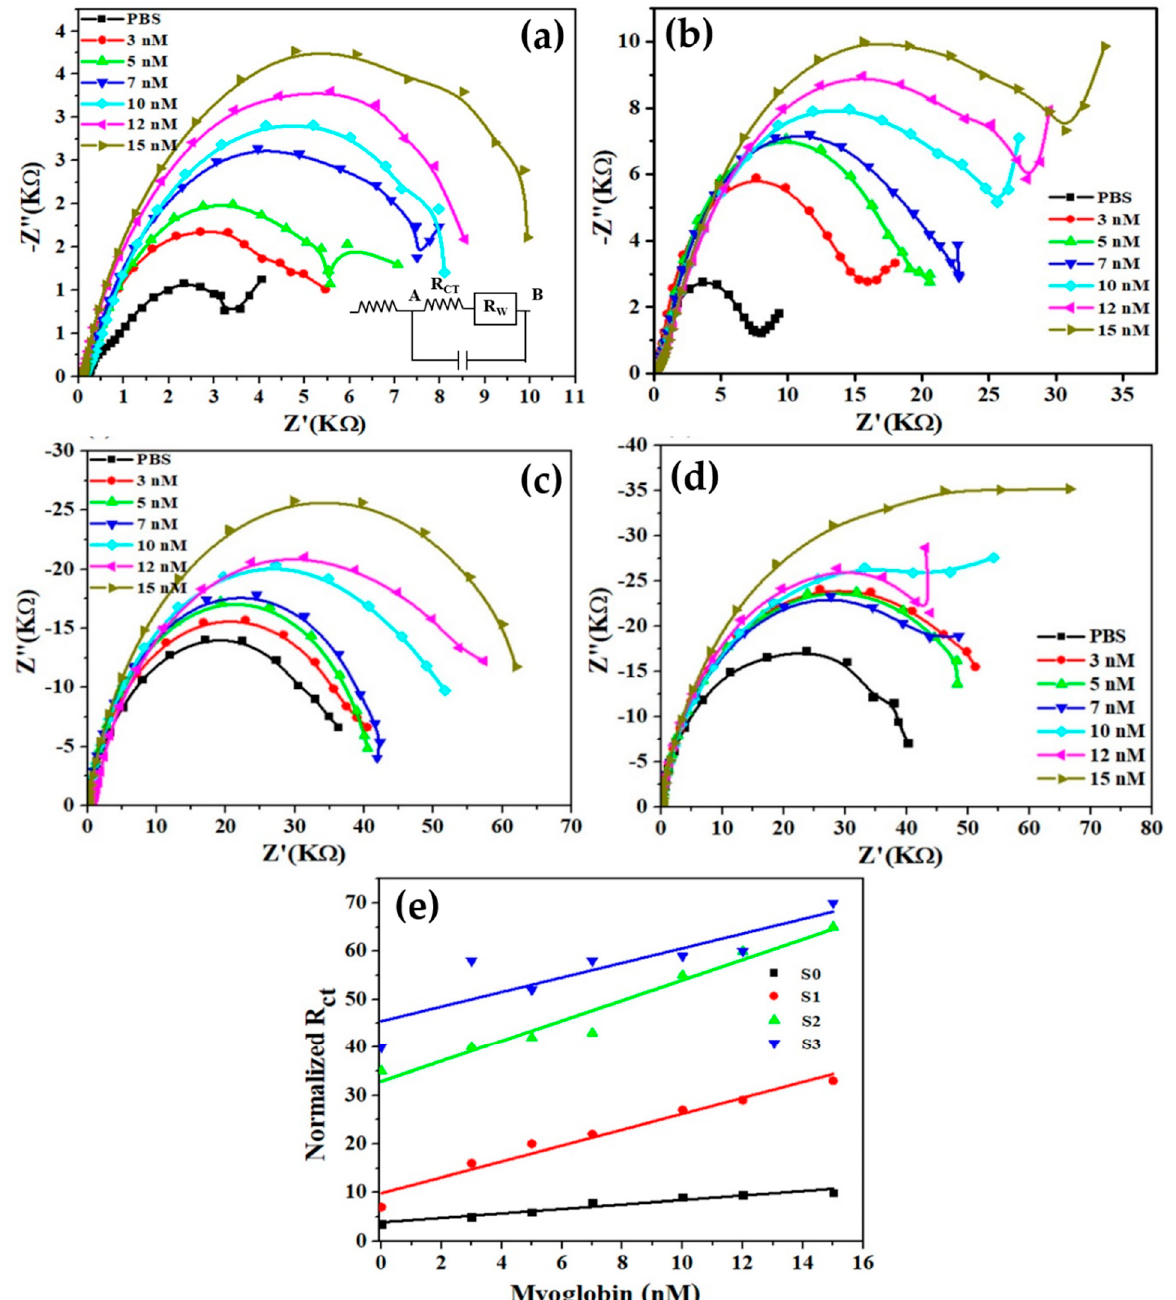
Figure 7. Series of Nyquist plots obtained from the pure ( a ) and ( b – d ) Cu-doped TiO 2 nanomaterials in absence and presence of various concentIions of Mb. ( e ) R ct values for different Mb concentration. The equivalent circuit of Nyquist curves is shown in the inset of Figure 7a. Here, point A represents the surface of the film, and point B corresponds to the solid liquid interface that constitutes the outermost layer of the double layer. Rw stands for diffusion impedance, or Warburg impedance, which is related to species diffusion and has a high value at